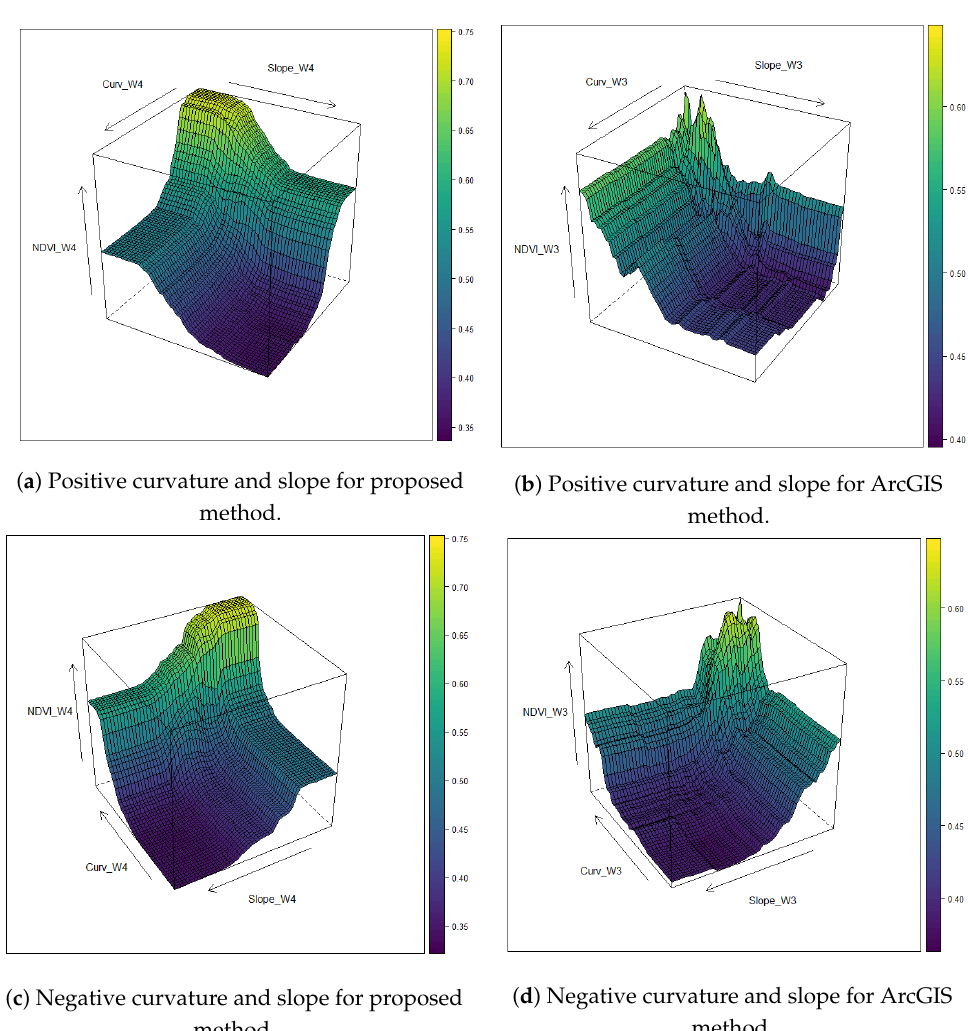
Figure 14. 3-D multi-attribute partial dependence plots for Curvature and Slope with